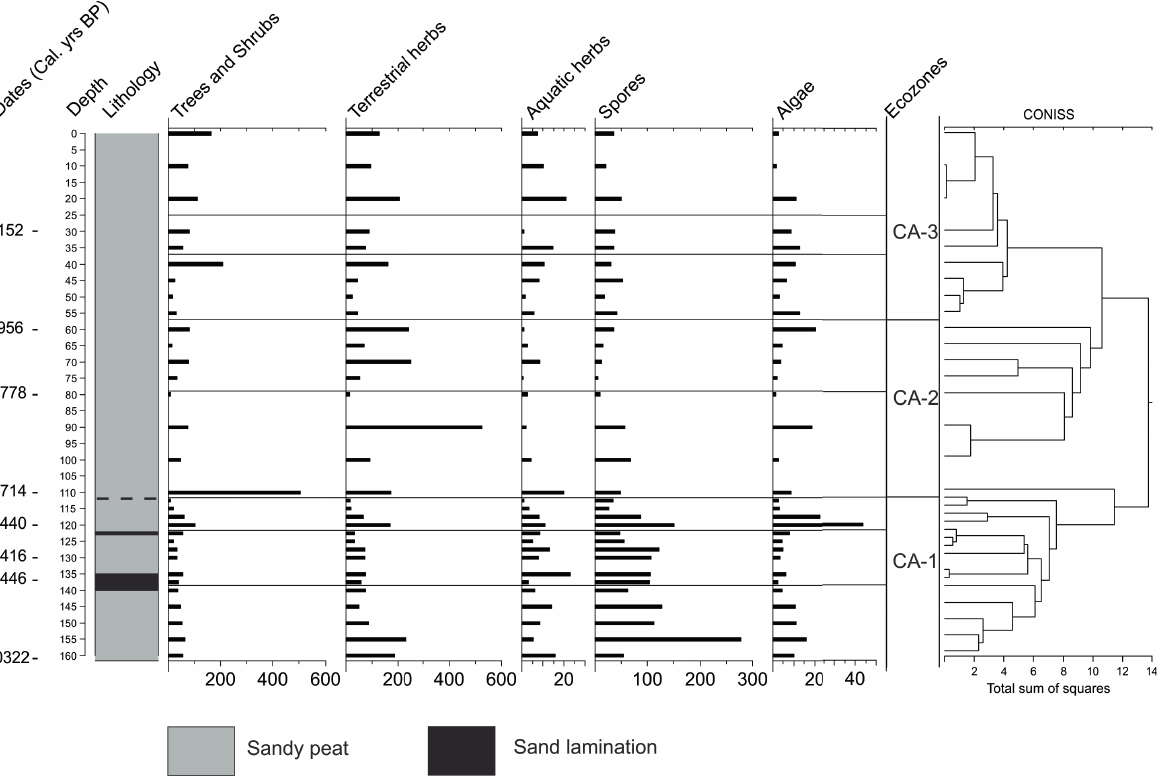
Figure 4 - Concentration pollen diagram of the Vale do Catimbau peat sequence of plant categories (x 1000). Dotted line at the lithology column marks a sedimentary